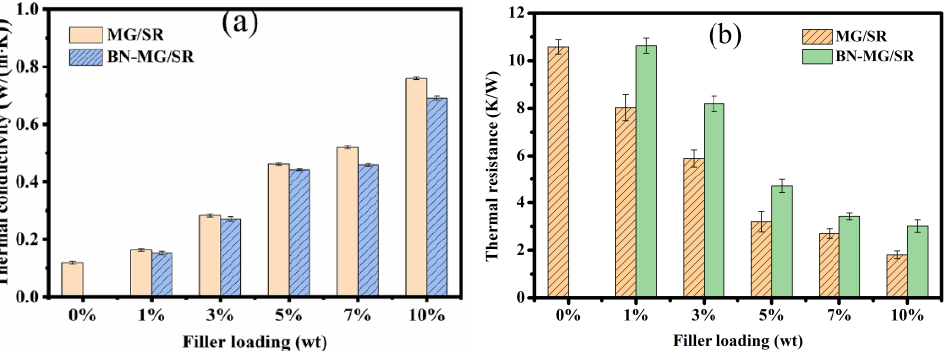
Figure 10. Thermal conductivity ( a ) and thermal resistance ( b ) of MG/SR and BN − MG/SR with different filler loading.